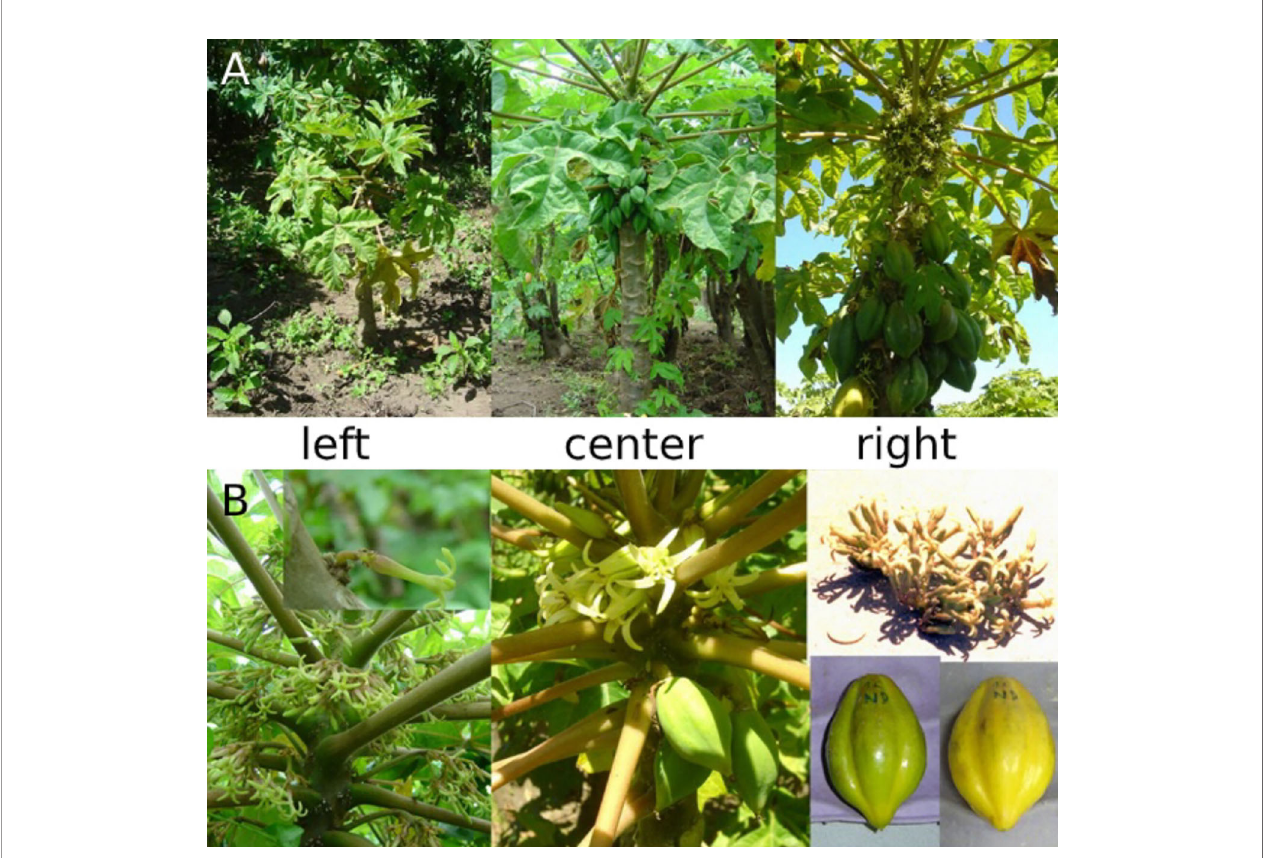
FIGURE 2 | Morphological characteristics of V. pubescens tree, fl owers and fruit. (A) Mountain papaya tree at three growing stages: a two month old tree of half a meter tall producing the fi rst fl owers (left); after one year, the tree reaches one meter tall and produces fruit (center); after three years, the tree is two meters tall, it is under full fruit production (right); interestingly, fruit at different developmental stages could be observed in the same tree. (B) Sexual forms in V. pubescens . Male plants produce staminate fl owers, showing their characteristic elongated form, with the stamen inside the fl ower (left). Female plants produce pistillate fl owers, with the characteristic enlargement of the fl ower base, because of ovary growth (center). Andromonoecious plants produce hermaphrodite and estaminate fl owers, where the fi rst ones differentiate from pistillate fl owers showing a wider enlargement of fl ower base (up right). The most notorious change during fruit ripening is the color change of fruit skin, varying from an intense green to bright yellow color (down